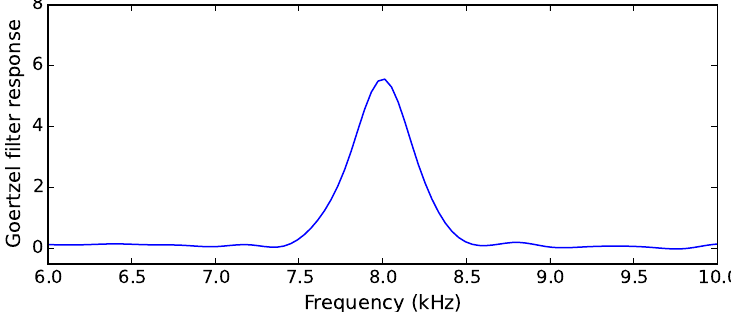
Figure 2. An 8 kHz tone extraction with a single Goertzel